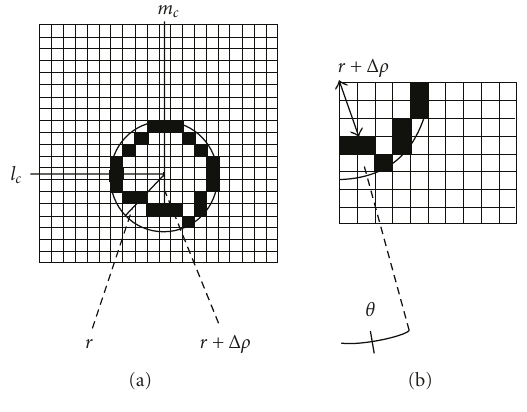
Figure 1: (a) An image containing a contour close to a circle with center coordinates ( l c , m c ); (b) bottom right quarter of the contour and pixel coordinates in the polar system ( ρ , θ ) having its origin on the center of the circle. r is the radius of the circle. Δ ρ is the value of the shift between a pixel of the contour and the pixel of the circle having the same coordinate θ . Δ ρ can be either positive or